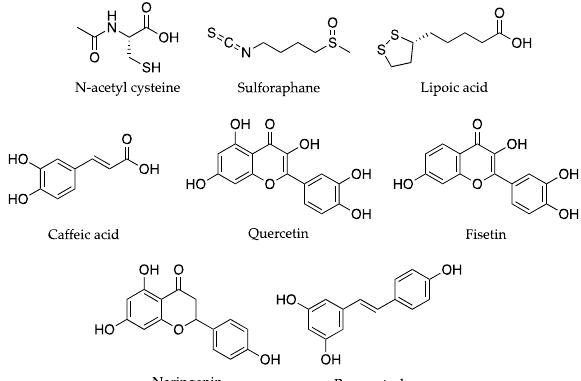
Figure 5. Chemical structures of natural compounds that directly or indirectly act as antioxidants, and which target mitochondrial decay.